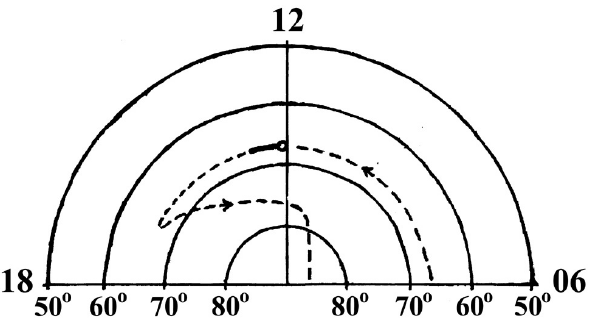
Fig. 9. The part of the convection trajectory around which the mag- netic field tube of plasma is carried in the numerical simulation under daytime conditions (dashed line). Arrows on the trajectory indicate the direction of the convection flow. The solid line marks the displacement of the plasma tube corresponding to the period of 80min after turn-on of the HF